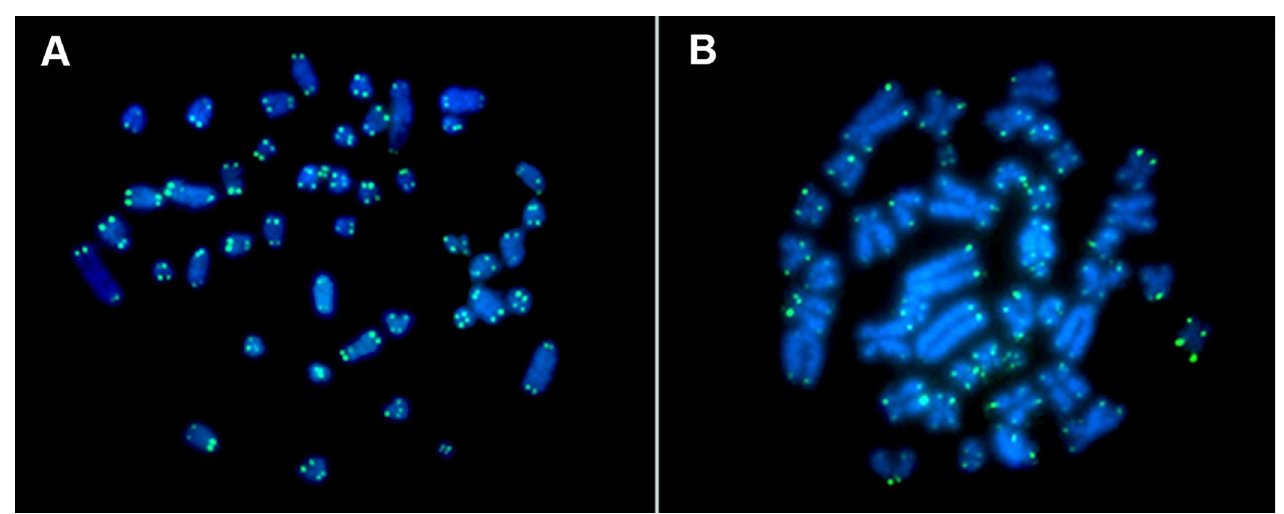
Fig 4. FISH with telomeric probes. (A) R . emiliae , (B) R . mastacalis .